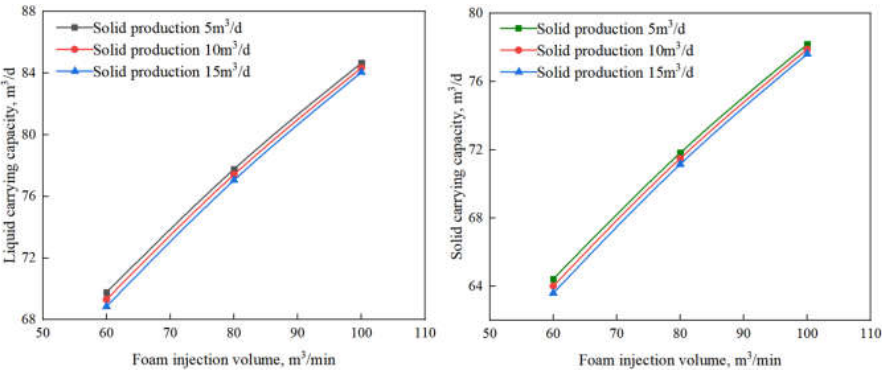
Figure 6. Variation rules of parameters under different foam injection volumes at different solid production values.